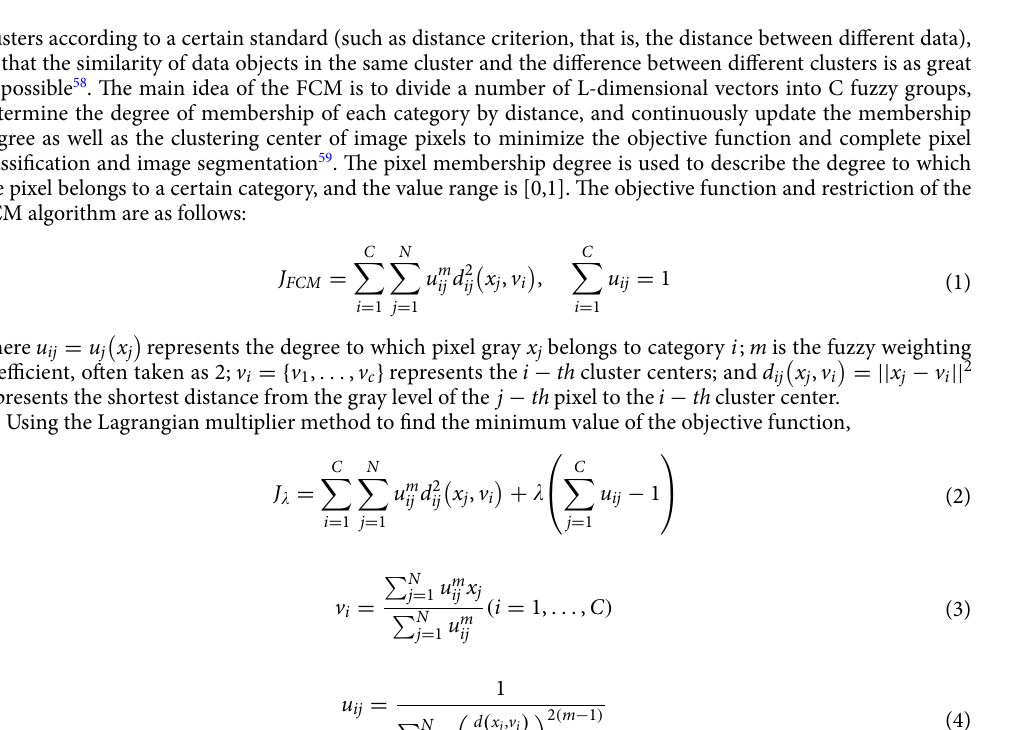
Figure 2. The underlying surface types and observation sites of the Qinghai-Tibet Plateau. (The data source of the land cover map comes from Ran et al. 52 , Software: ArcGIS 10.5, https:// www. arcgis. com/ index.